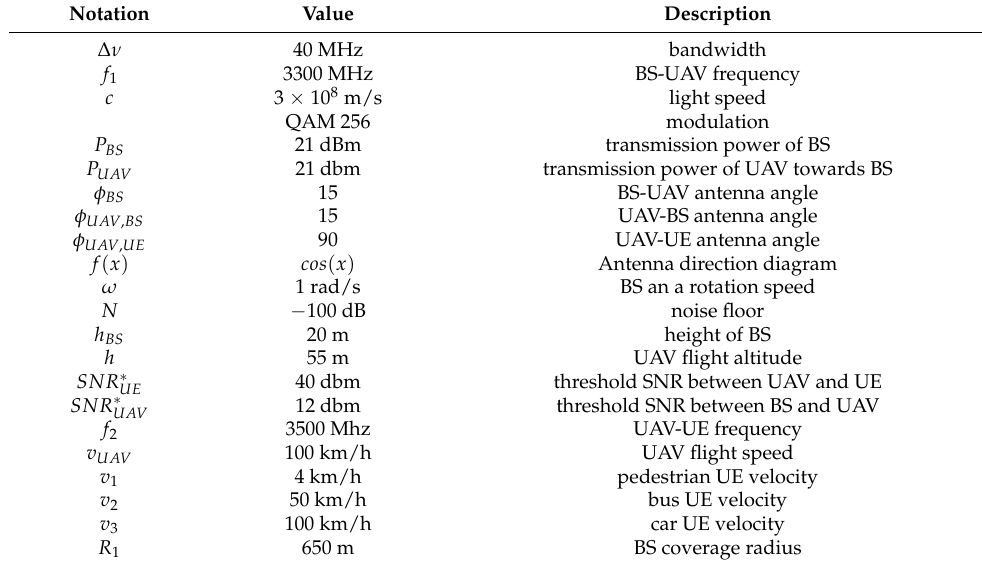
Table 2. Initial data.